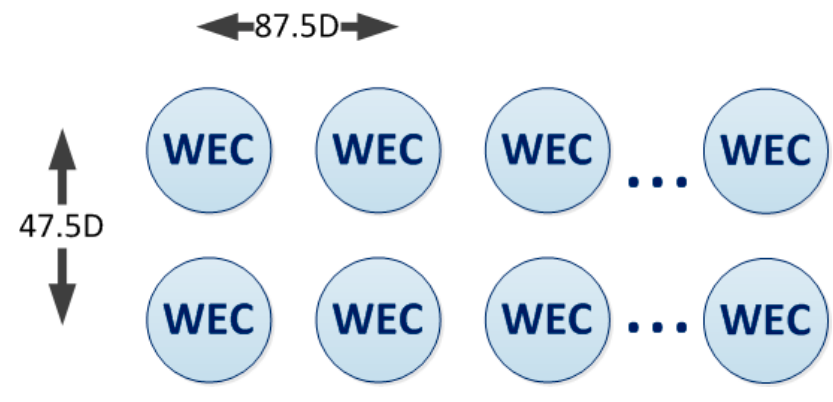
Figure 2. Configuration of the wave farm grid.